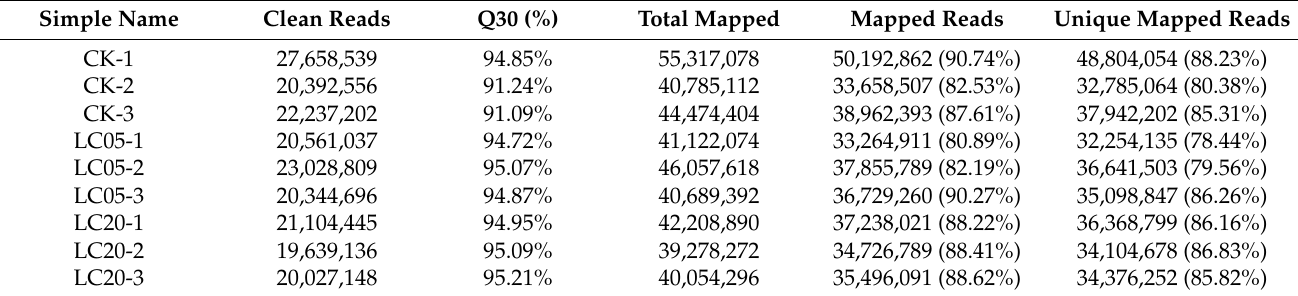
Table 1. Sequencing data quality analysis and reference genome comparison results.